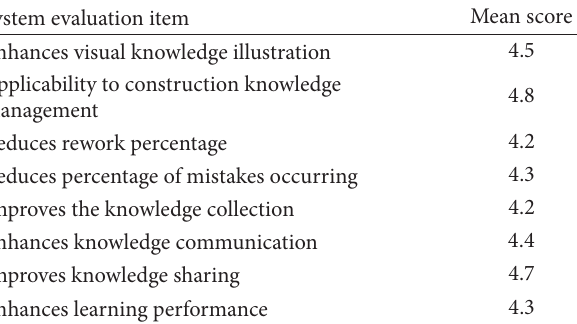
Table 1: System evaluation